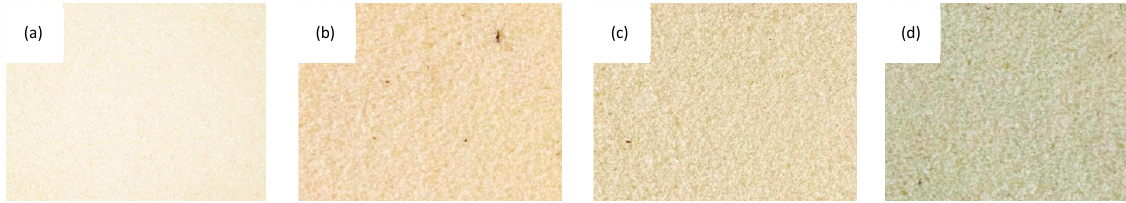
Figure 9. Optical images of ( a ) PUR_NEAT; ( b ) PUR_C_1; ( c ) PUR_C_2; ( d ) PUR_C_5 Table 2. Color parameters of PUR composites measured before and after the UV-aging.